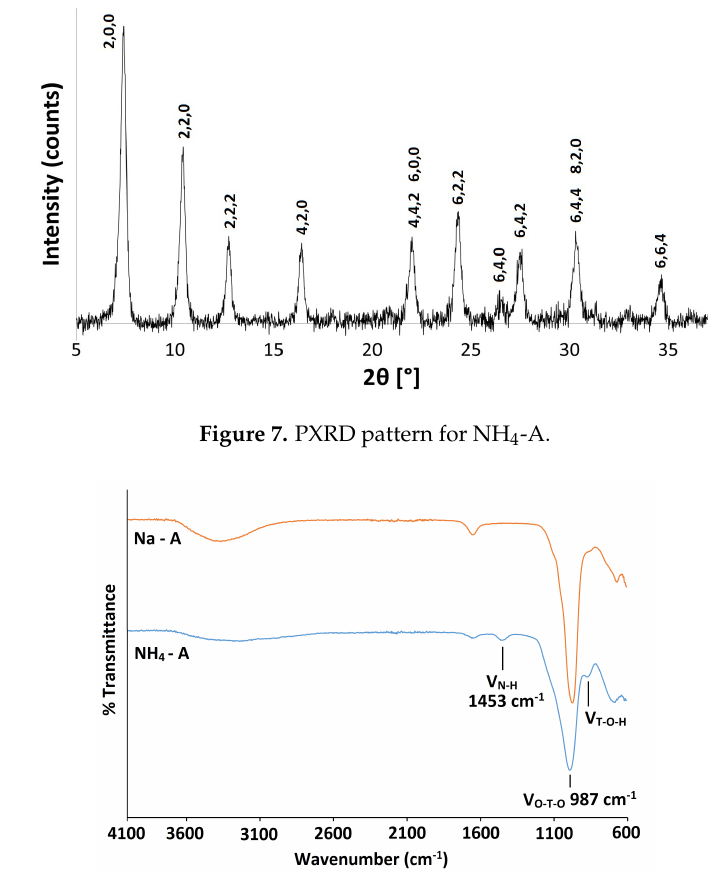
Figure 8. FT-IR spectra for the parent Na-A zeolite (orange line) and NH 4 -A (blue